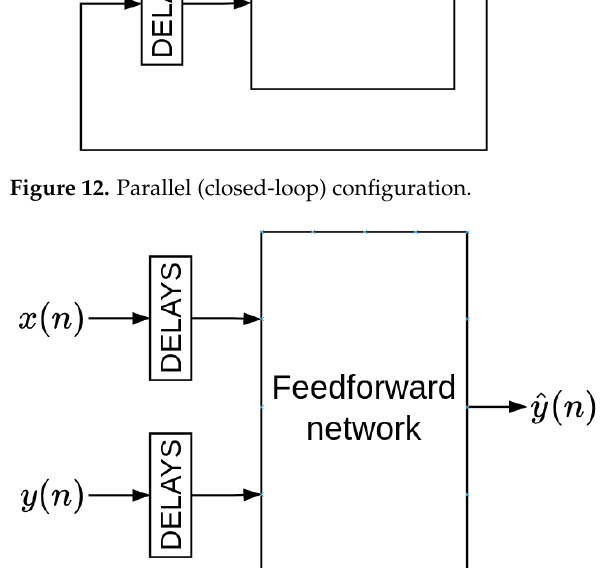
Figure 13. Series-parallel (open-loop)